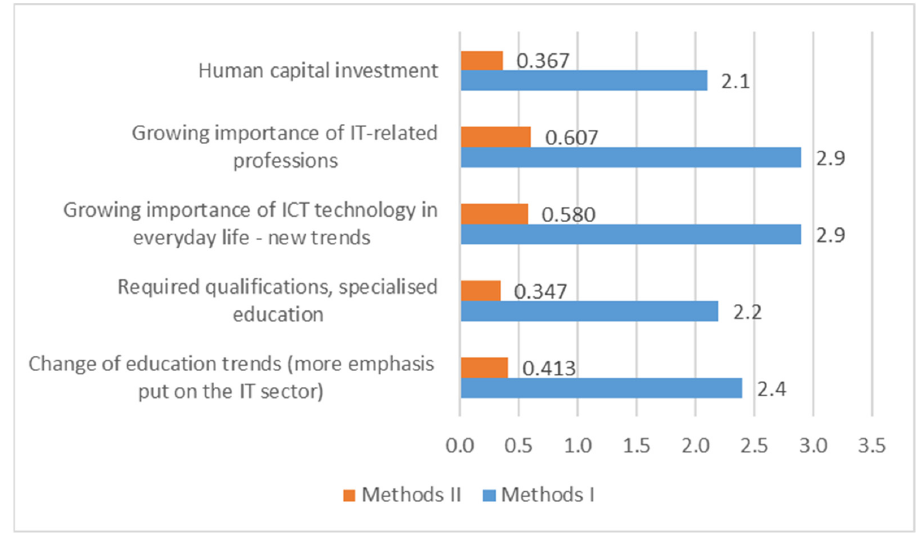
Figure 9. Summary of the results for social factors with both methods. Authors’ own study.